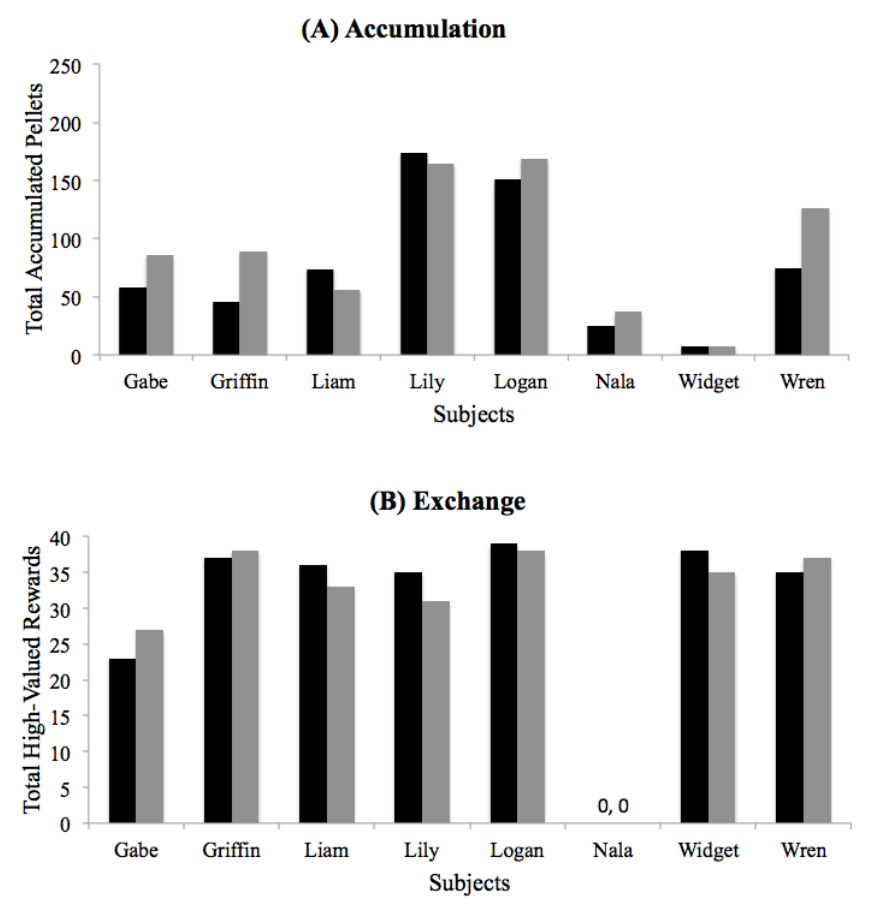
Figure 5. Experiment 2 test performance for the ( A ) accumulation self-control task, including the total number of pellets accumulated (maximum: 250 pellets) when the accumulation task was presented first (black bars) and when the accumulation task was presented second (gray bars). Test performance for the ( B ) exchange self-control task, including the total number of higher-valued rewards obtained (maximum: 40 mini-marshmallows) when the exchange task was presented first (black bars) and when the exchange task was presented second (gray